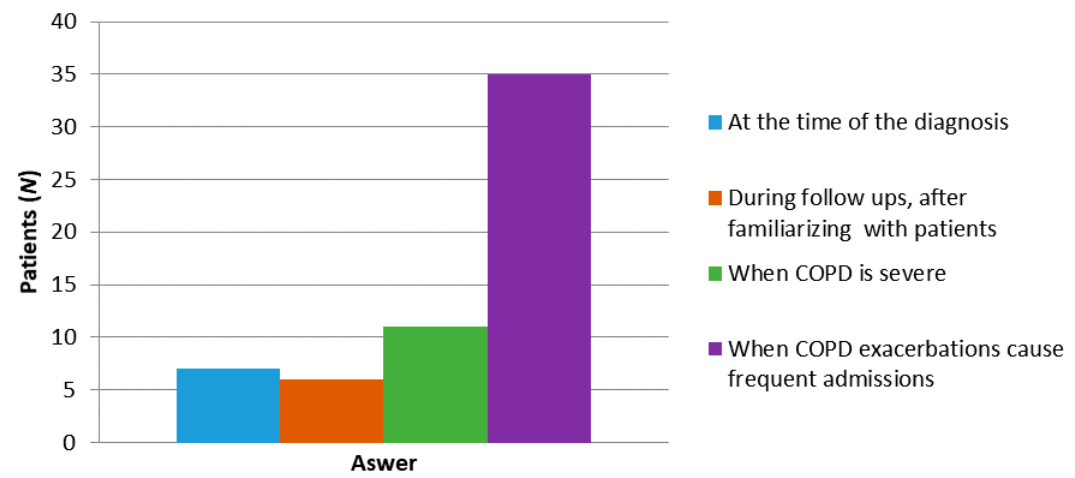
Figure 4. Patients’ preferences regarding the timing of the EOLC discussion.